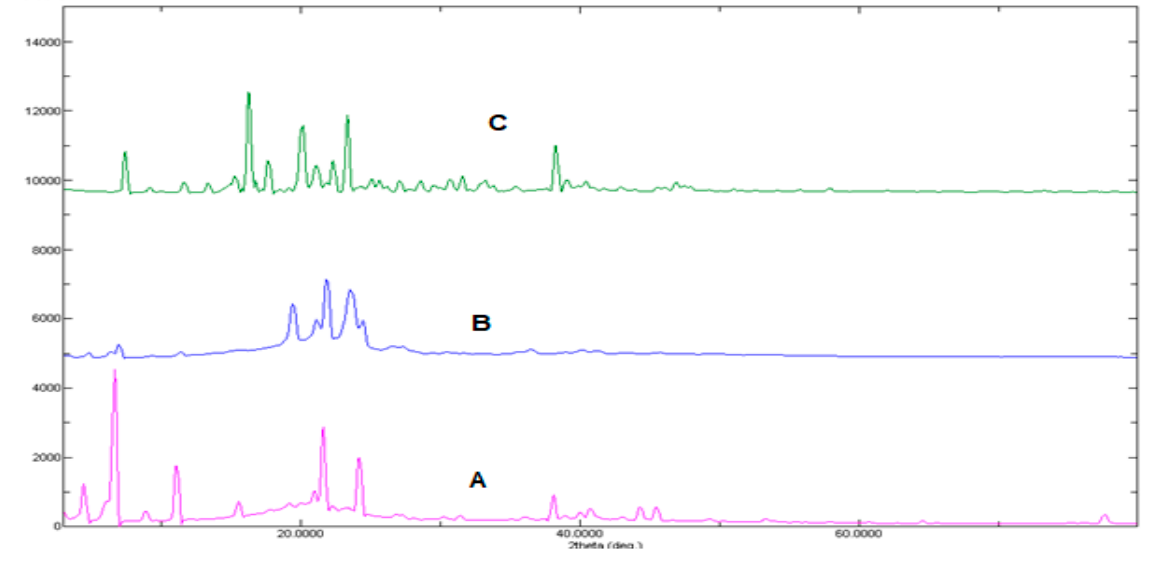
Figure 4. DSC thermograms of A: Pure QTF, B: Lecithin, stearic acid, and Pluronic F-127 mixture, C: Lecithin, stearic acid, Pluronic F-127, and QTF, and D: the best formula.